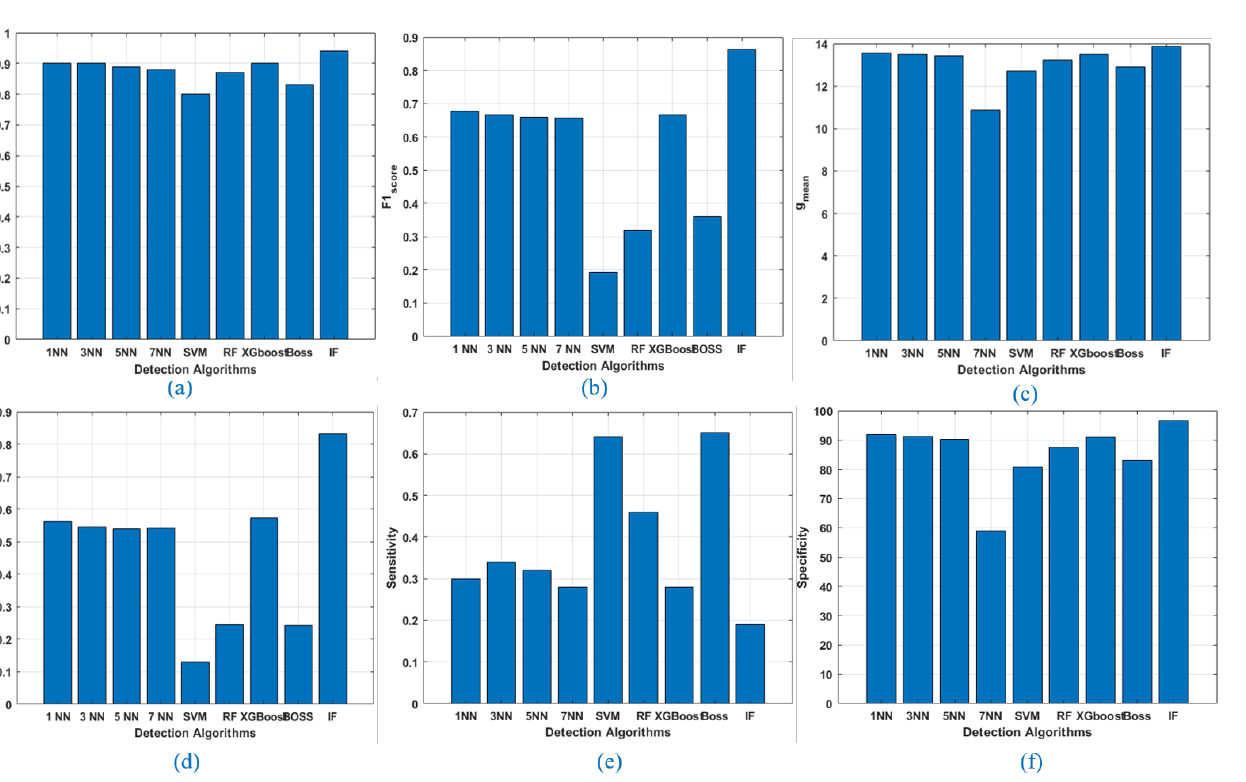
Figure 4. Performance Evaluation for several metrics for 6 h granularity, ( a ) accuracy, ( b ) F1 score , ( c ) g mean , ( d ) precision, ( e ) sensitivity, and ( f )